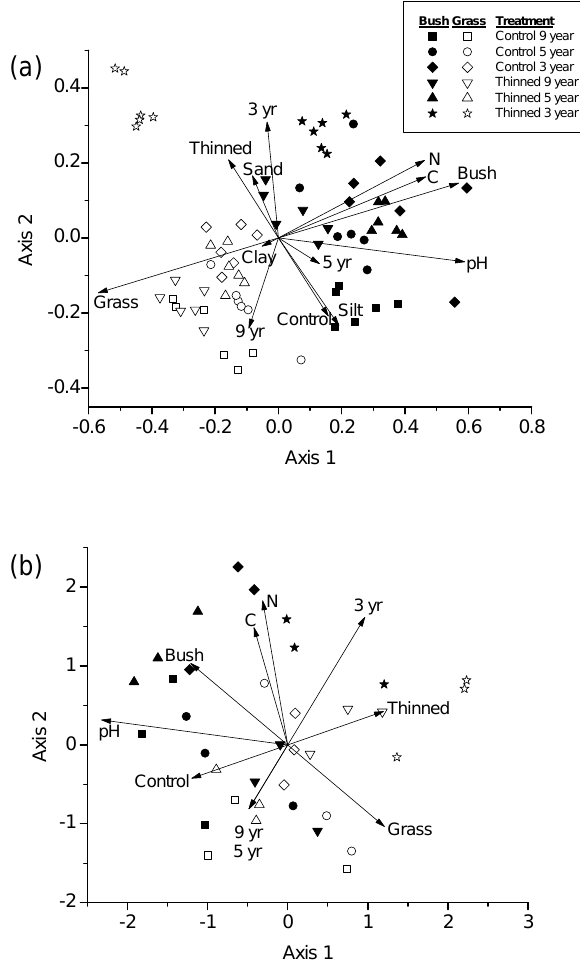
Figure 4. Redundancy analysis of bacterial TRFLP. (a) May and August 2012. (b) November 2013. Vectors indicate the correlations between each factor and the axes. Very small vectors were elimi- nated for the sake of clarity.